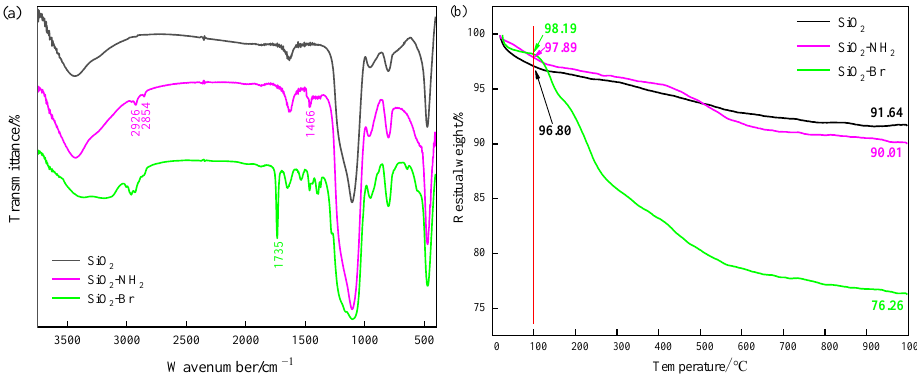
Figure 1. ( a ) IR spectra and ( b ) TGA curves of SiO 2 , SiO 2 -NH 2 , and SiO 2 -Br. The verification of BA and DMAEMA grafting onto the silica surface was obtained by the FTIR and GPC analysis of SiO 2 -g-PBA-b-PDMAEMA shown in Figure 2. The peaks in the FTIR spectrum at 2958 cm − 1 and 2821 cm − 1 were attributed to the stretching vibration of C-H in the PBA and PDMAEMA chains. The peaks at 1732 cm − 1 were attributed to the stretching vibration of C=O. The peaks at 1105 cm − 1 were attributed to the stretching vibration of Si-O-Si. The FTIR spectrum of SiO 2 -g-PBA-b-PDMAEMA showed that PBA and PDMAEMA chains were successfully grafted onto the silica initiator SiO 2 -Br. Furthermore, after etching by hydrofluoric acid, the molecular weights ( M n ) of PBA-b-PDMAEMA cleaved from SiO 2 -g-PBA-b-PDMAEMA were 32,930 g · mol − 1 for S1 and 38,420 g · mol − 1 for S2, which were close to the theoretical value for the single arm (45711 g · mol − 1 for S1 and 45,421 g · mol − 1 for S2, calculated from Table 1). The polydispersity indexes (PDIs) were 1.304 for S1 and 1.391 for S2, which revealed the narrow distribution of the molecular weights. GPC results illustrated that the polymerizations initiated by SiO 2 -Br were all typically controllable ATRP, and the PBA-b-PDMAEMA chains were grafted as